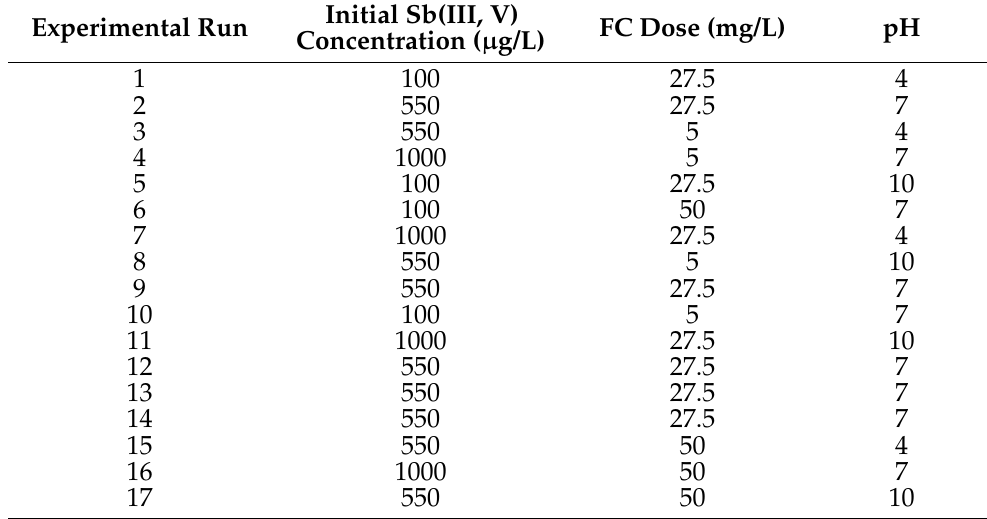
Table 2. Experimental data points used in Box–Behnken experimental design.